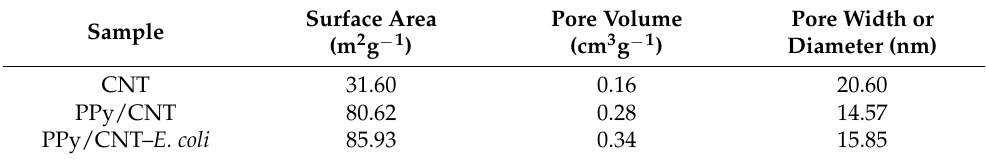
Table 1. Surface area, pore-volume, and pore diameter values of CNT, PPy/CNT, and PPy/CNT– E. coli